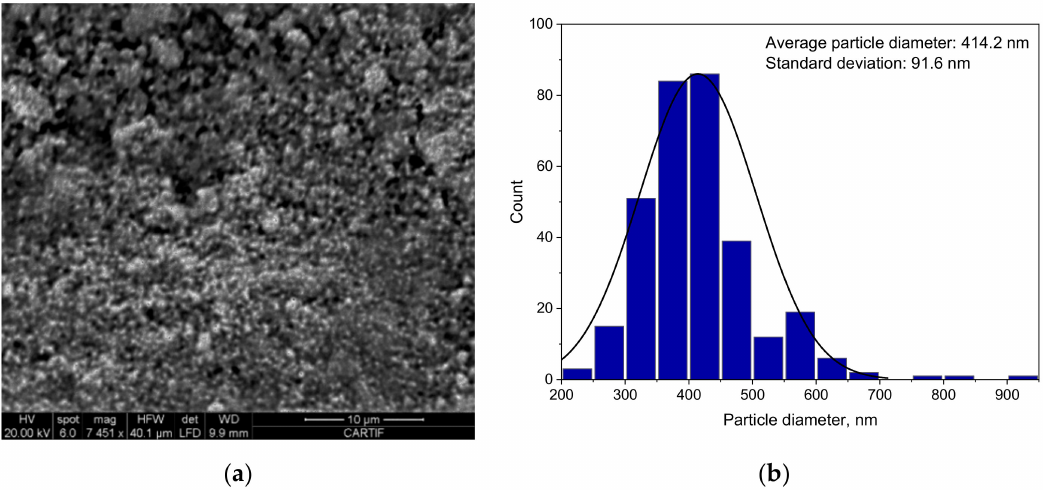
Figure 5. SEM micrograph ( a ) and histogram ( b ) of the calcined Ni–Fe–Cu/LDH at 40.1 µ m (HFW).